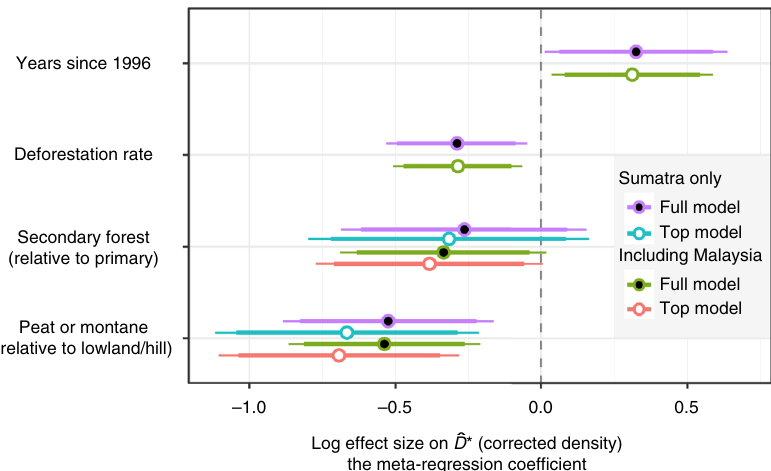
Fig. 3 Variation in tiger densities through time and between habitats. Results from mixed model meta-regressions explaining variation in log( ^ D *) showing 90% CI (thick lines) and 95% CI (thin lines). Top model (white fi ll) based on AICc values included habitat and degradation (secondary forest). Full model (black fi ll) including time and deforestation rates had marginally higher AICc values (+3.3). Malaysia estimates were not signi fi cantly different than Sumatra ’ s accounting for forest type and disturbance (LRT: χ 1 = 0.67, P = 0.41) and the top Sumatra-only model also included forest type and disturbance (LRT S : χ 2 = 7.93, P = 0.02, R 2 = 0.50) and supported lower densities in peat and montane forests ( − 48.6%; MRMM S : z = − 2.90, P = 0.01), and logged areas ( − 27.2%; MMRM S : z = 1.29, P = 0.21). Including deforestation and time signi fi cantly improved the Sumatra-only model fi t (LRT S : χ 2 = 8.65, P = 0.01, for multiple estimates from the same landscape